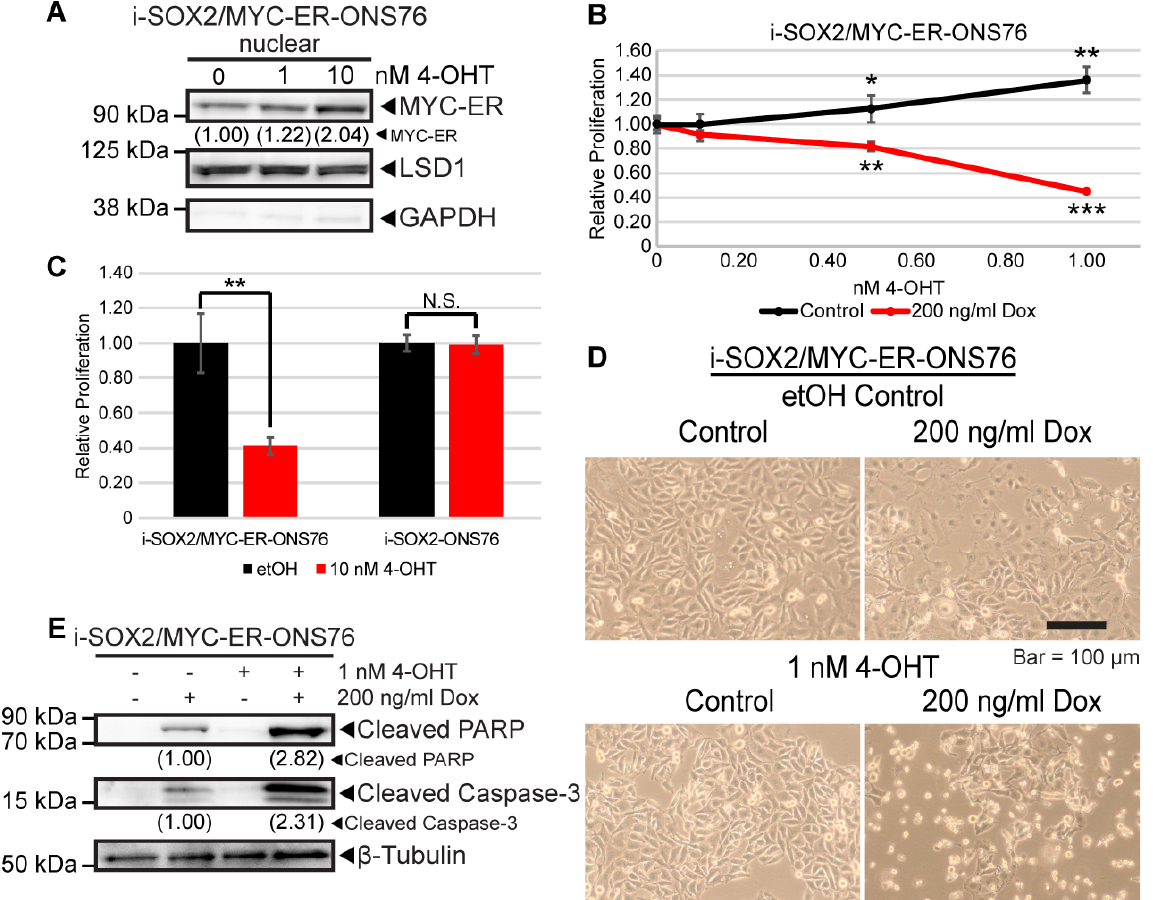
Figure 7. Elevated MYC activity in the context of elevated SOX2 induces cell death. ( A ) Western blot analysis of nuclear extracts from i-SOX2/MYC-ER-ONS76 cells. Extracts were harvested after 48 h in the presence or absence of Dox and 4-OHT. ( B ) Proliferation of i-SOX2/MYC-ER-ONS76 cells as determined by MTT assay following 4 days of culture in the presence of Dox and 4-OHT at the indicated doses. ( C ) Proliferation of i-SOX2/MYC-ER-ONS76 and i-SOX2-ONS76 cells was deter- mined by MTT assay following 4 days of culture in the presence or absence of 10 nM 4-OHT. ( D ) Photomicrographs of i-SOX2/MYC-ER-ONS76 cells after 4 days of culture in the presence or absence of Dox and 4-OHT. ( E ) Western blot analysis of cleaved PARP and cleaved Caspase-3 using whole cell extracts prepared from cells treated for 48 h in the presence or absence of Dox and 4-OHT at the concentrations indicated. N.S., not significant; * p < 0.05, ** p < 0.01, *** p < 0.001.